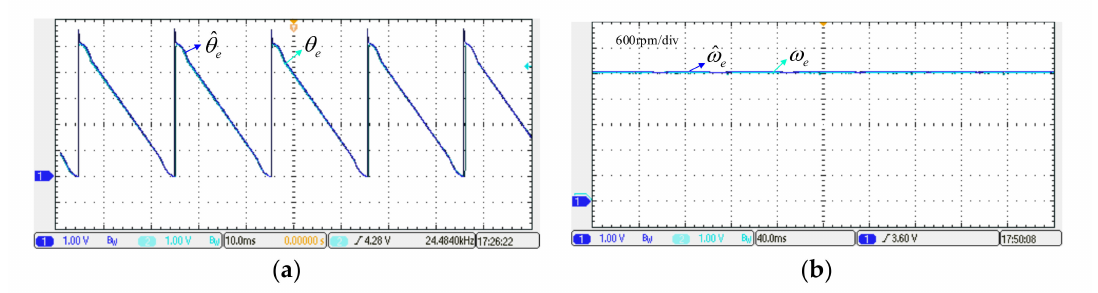
Figure 17. The experimental results using the proposed method when the rotor speed was3000 rad / min. ( a ) the measured and estimated rotor positions, ( b ) the measured and estimated rotor